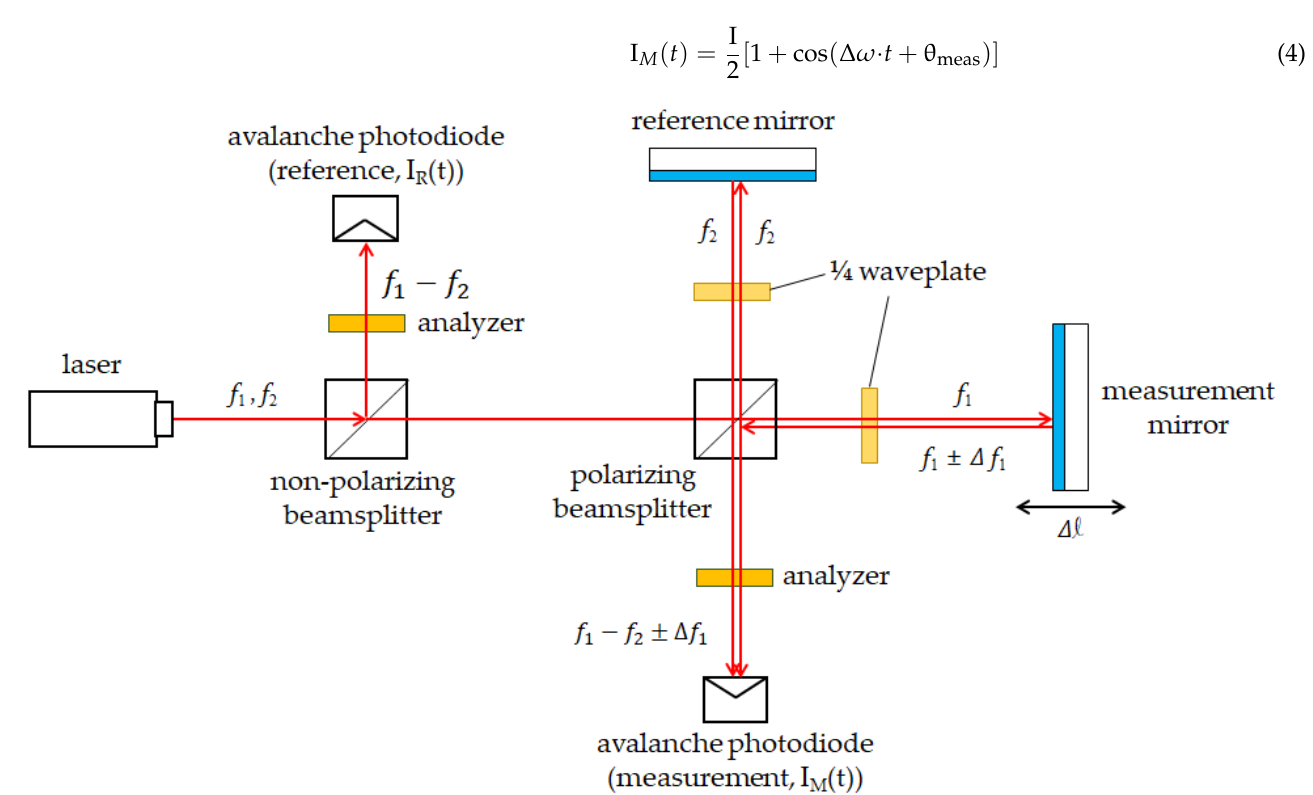
Figure 3. The optical structure of the heterodyne interferometry − based encoder.